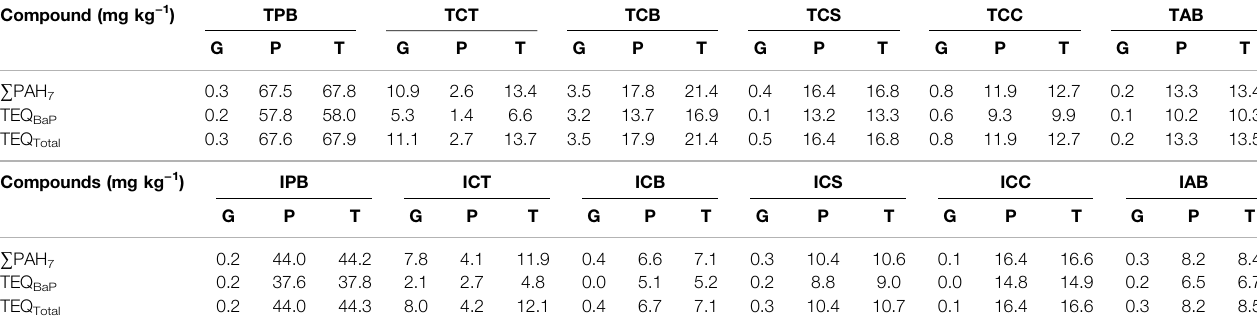
TABLE 4 | Carcinogenic risks posed by PAHs emitted from crop residues burning in two types of stoves. Compound (mg kg − 1